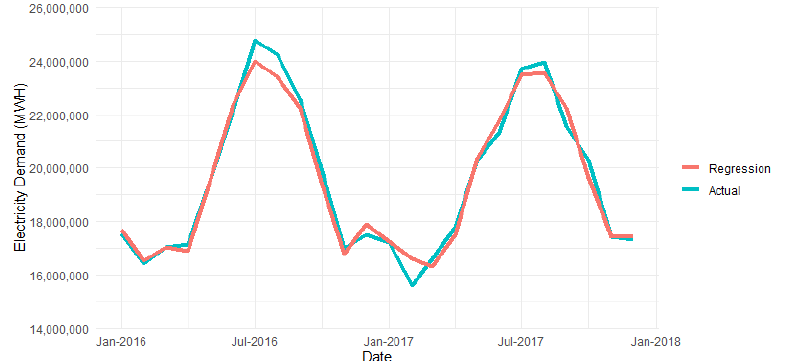
Figure 8. Actual vs. predicted regression